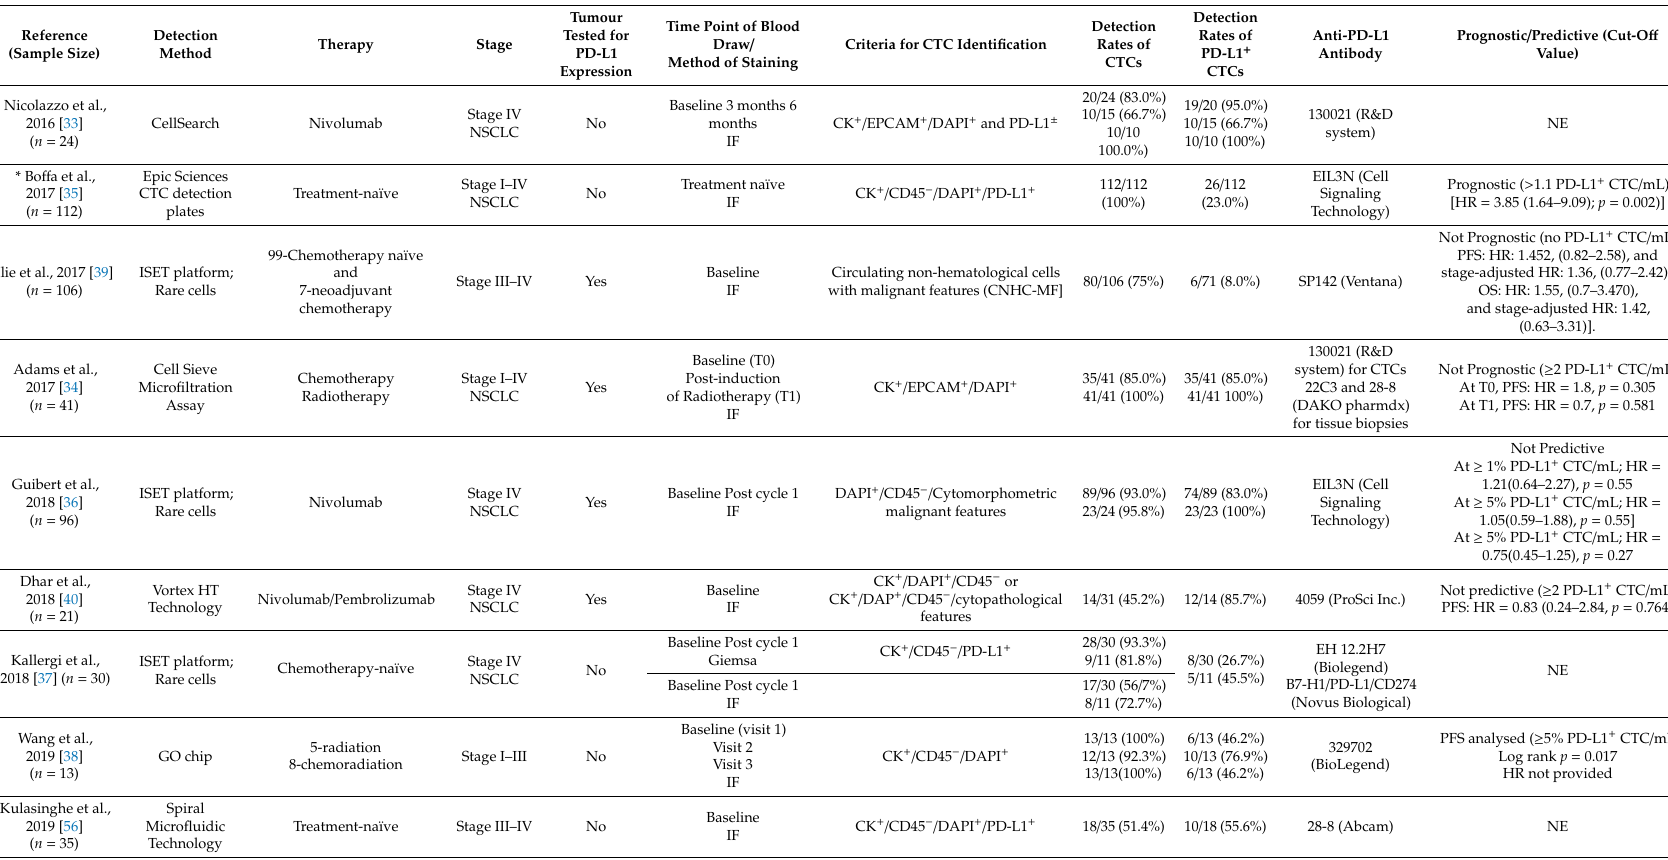
Table 1. Prospective studies evaluating programmed cell death ligand-1 (PD-L1) on circulating tumour cells (CTCs) in